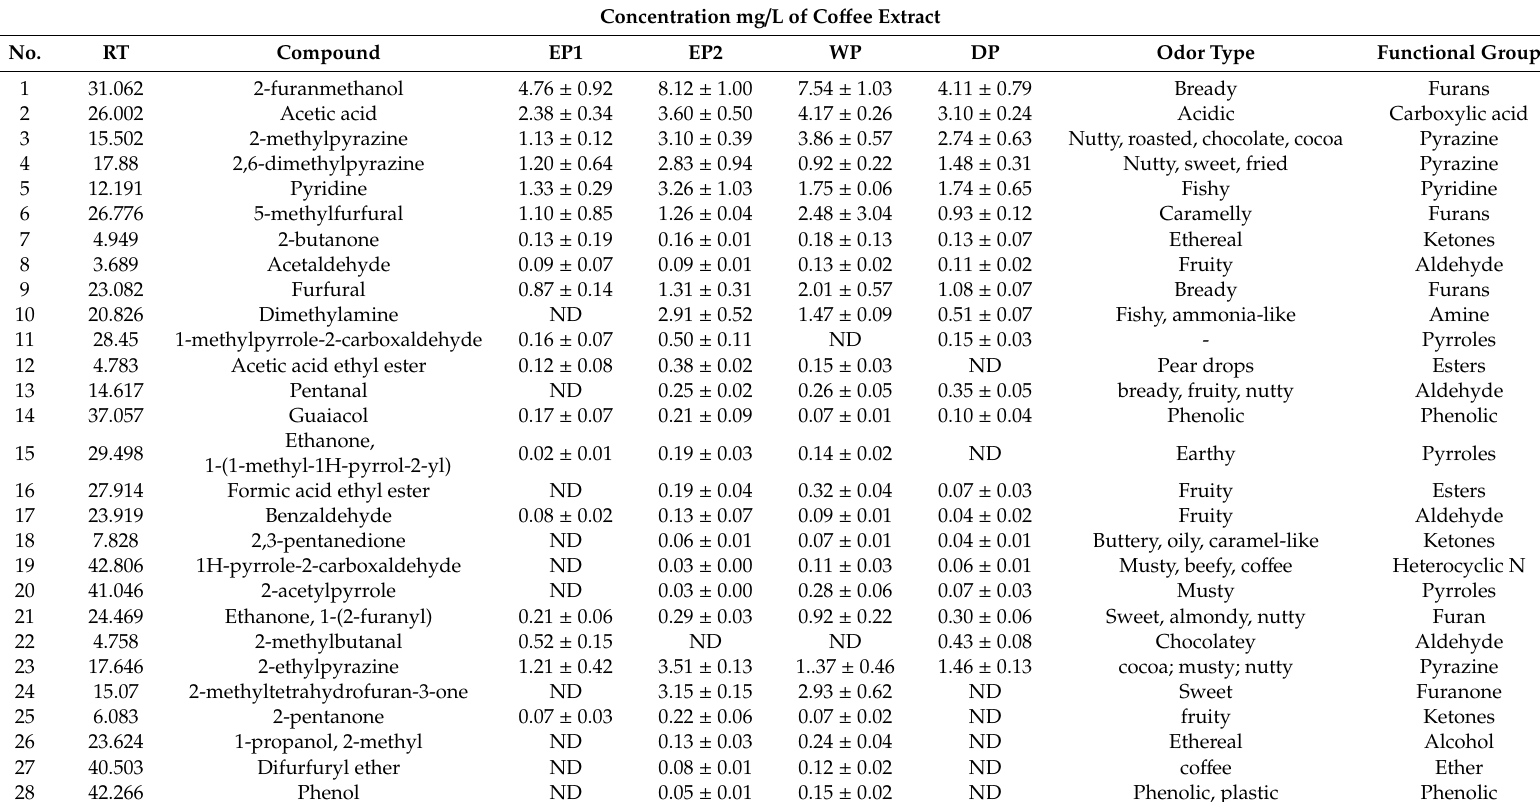
Table 2. Volatile compounds identified from co ff ee beans obtained using di ff erent processing methods (EP1, EP2, WP, and DP). Concentration mg / L of Co ff ee